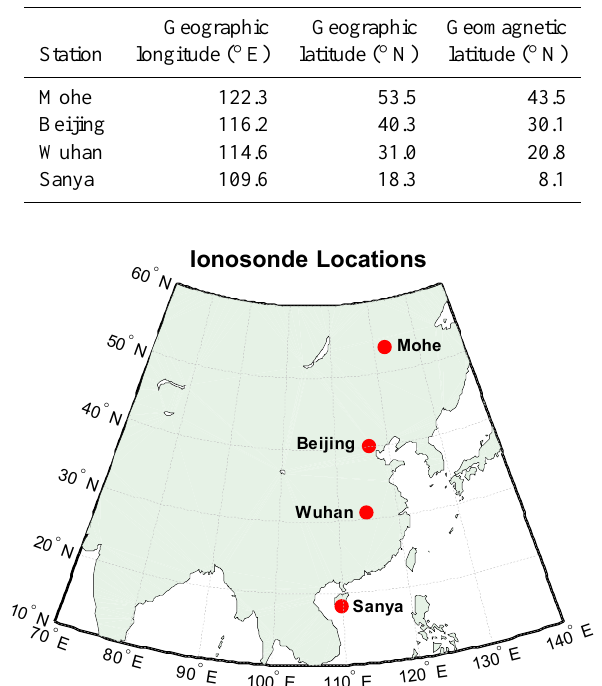
Figure 1. The ionosonde locations in the observation chain in Fig.1. The ionosonde locations in the observation chain in China.